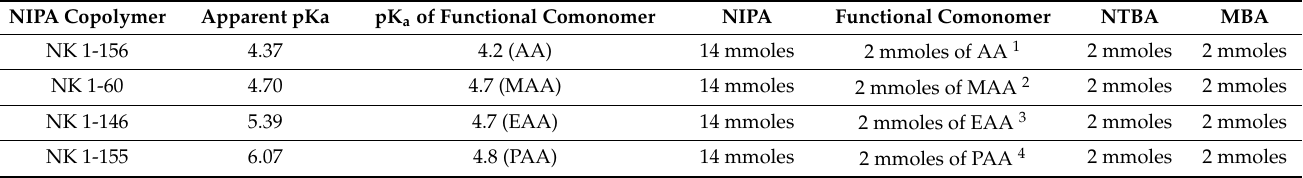
Table 4. Comparison of Alkyl Acrylic